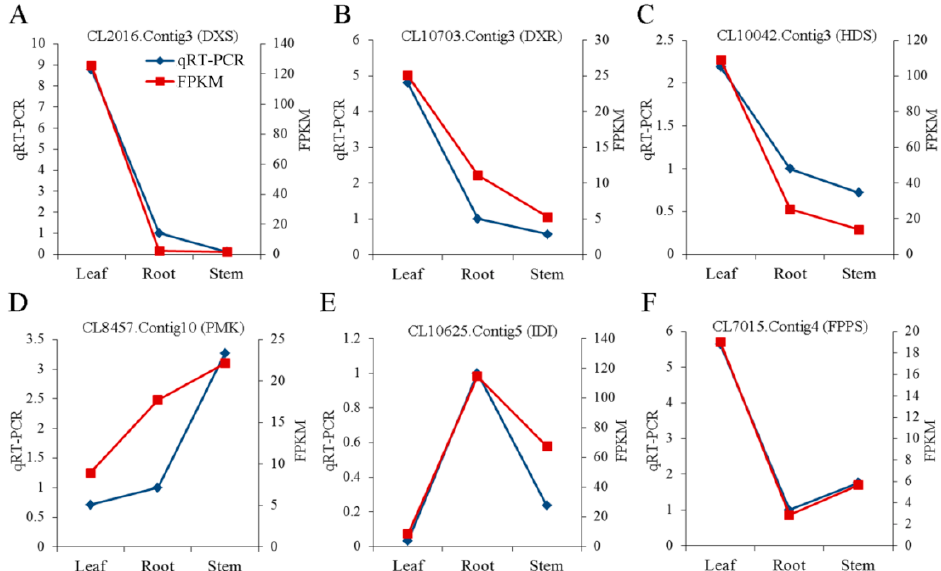
Figure 9. qRT-PCR analysis of unigenes encoding enzymes involved in triterpenoid saponin biosynthesis. Relative expression of ( A ) CL2016.Contig3 (DXS), ( B ) CL10703.Contig.3 (DXR), ( C ) CL10042.Contig3 (HDS), ( D ) CL8457.Contig10 (PMK), ( E ) CL10625.Contig5 (IDI), and ( F ) CL7015.Contig4 (FPPS) was analyzed by qRT-PCR using the actin gene (Unigene1915) as the reference gene for normalization. Red lines indicate the FPKM values of these unigenes, and blue lines indicate the qRT-PCR results.